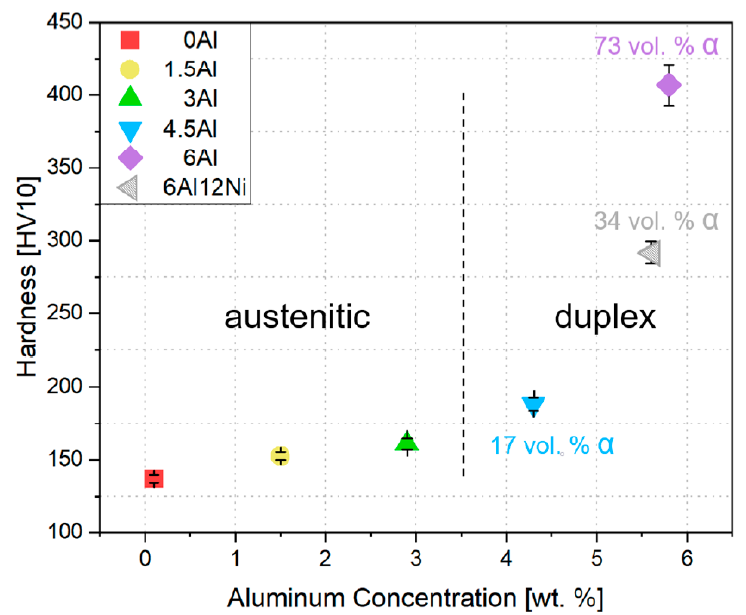
Figure 9. Vickers hardness as a function of Al concentration. Hatched fill for the 6Al12Ni alloy is meant to emphasize its higher Ni content compared to the rest of the alloys. Ferrite fractions marked for the duplex steels are EBSD-based.